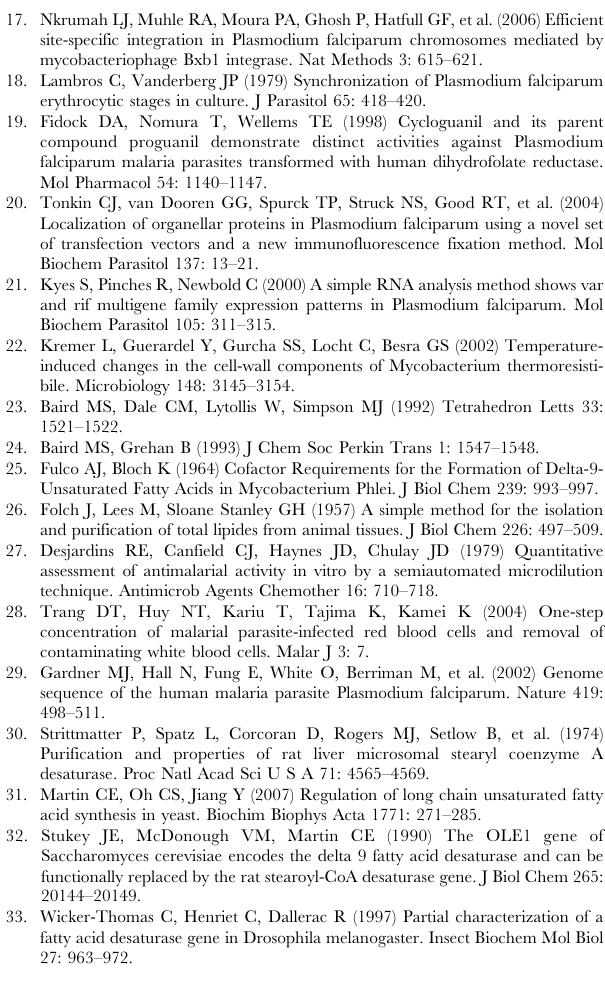
Figure S2 Isobologram plots of MeSter plus oleic acid tested against P. falciparum cultures.